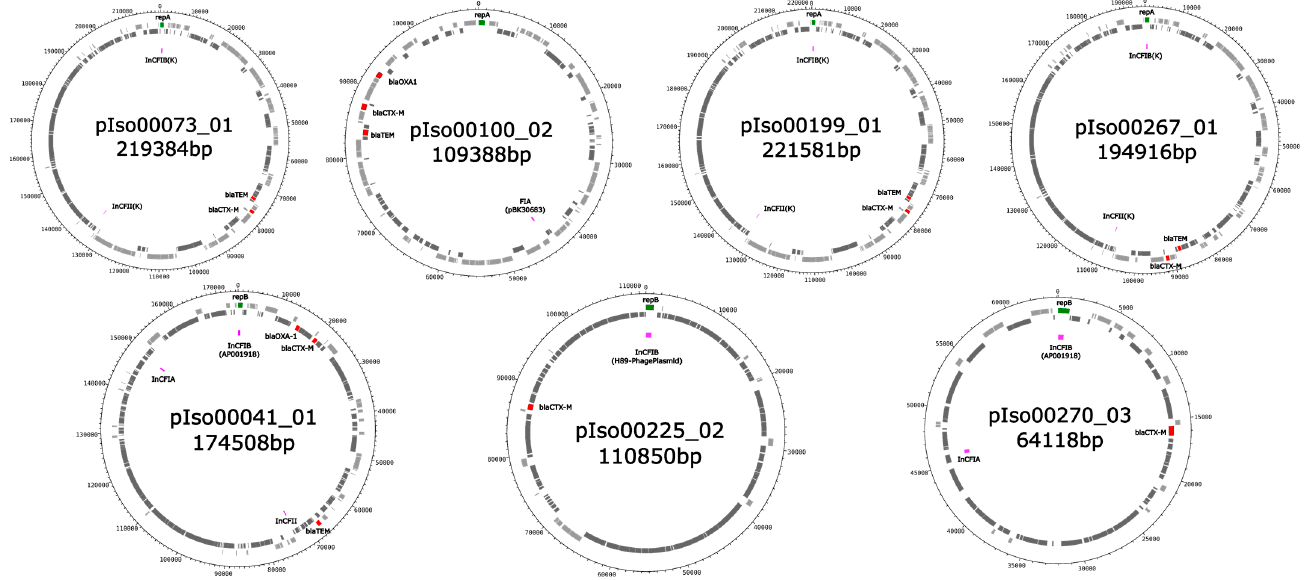
Figure 1. Visualization of the bla CTX-M -gene-carrying plasmids. Upper row: Plasmids detected in K. pneumoniae . Lower row: Plasmids detected in E. coli . Genes located on the forward and reverse strand are colored in light and dark grey, respectively. Bla genes are shown in red. Genes coding for replication-associated proteins and marking the start gene of the sequence are shown in green. PlasmidFinder matches are shown in